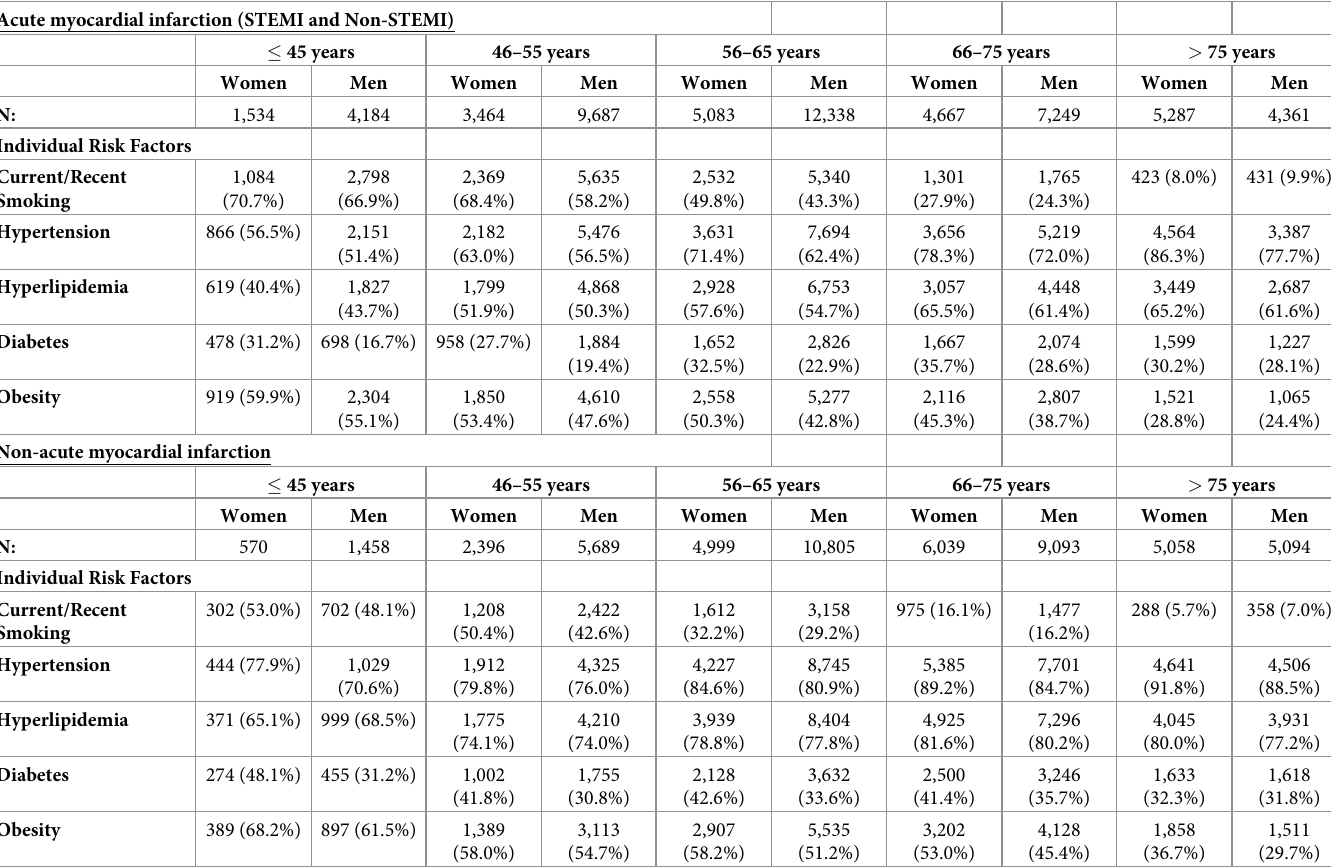
Table 2. Prevalence of risk factors by age and gender among patients who underwent percutaneous coronary intervention for the treatment of acute myocardial infarction and non-acute myocardial infarction presentations. Acute myocardial infarction (STEMI and Non-STEMI)